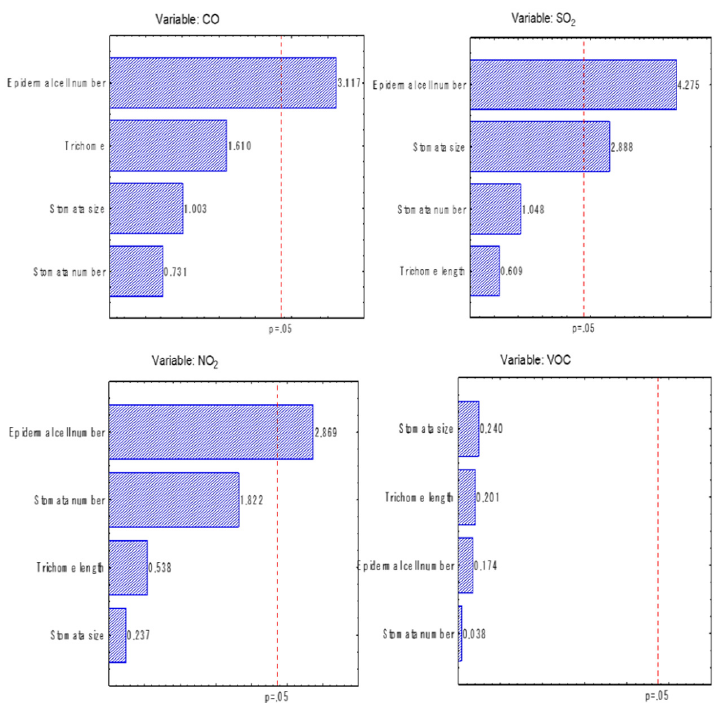
Figure 3. Pareto chart of t-values for coefficients from multiple regression for Ficus